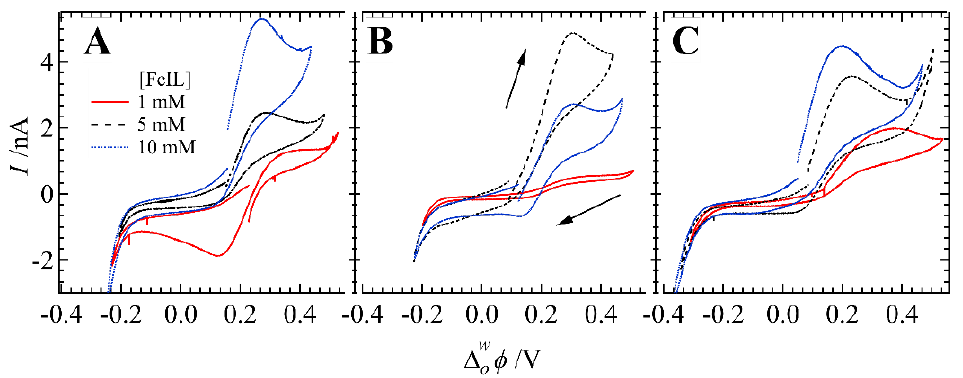
Figure 3. Voltammetric responses for increasing additions of [FcIL], y as indicated inset to the DCE phase, with [KAuCl 4 ] = 1 mM in Cells 1a – 3a or pH 2 ( A ), 5.5 – 6 ( B ), and 8.5 ( C ). A 0.020 V s – 1 scan phase, with [KAuCl 4 ] = 1 mM in Cells 1a–3a or pH 2 ( A ), 5.5–6 ( B ), and 8.5 ( C ). A 0.020 V s –1 scan rate rate was employed with a 25 µm diameter ITIES, while the scan direction is indicated by black ar- was employed with a 25 µ m diameter ITIES, while the scan direction is indicated by black rows.